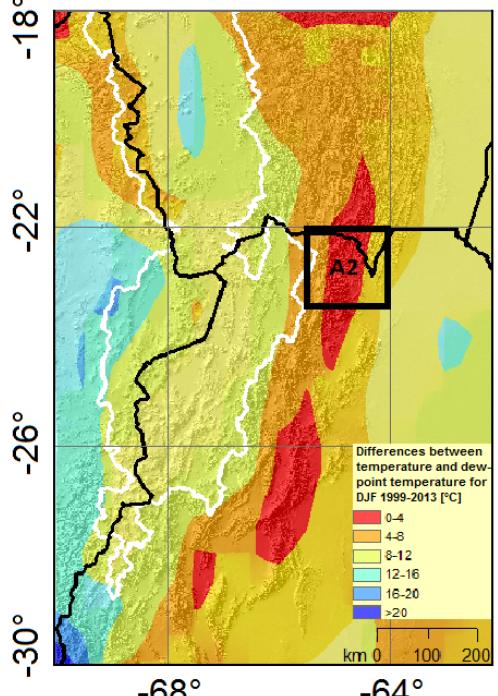
Figure 16. The small differences between dew-point temperature and air temperature during austral summer (1999–2013) over the tropical and the intermediate-elevation area explains the high contribution of dew point temperature in extreme rainfall in this region (Figure 4A, Box A2). White line outlines the central Andean Plateau, black lines are international